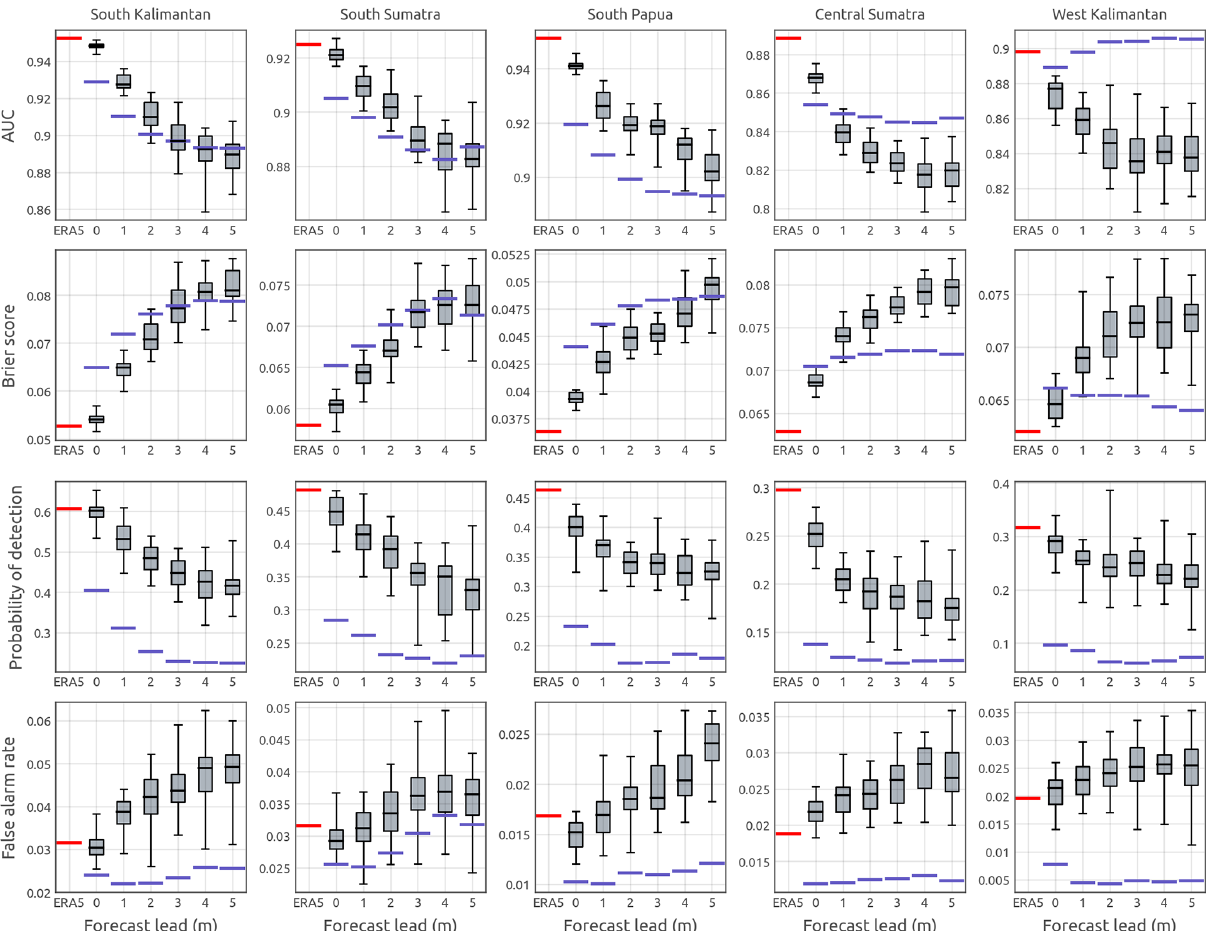
Figure 7. Skill scores for prediction of an active-fire count of > 10 cases. Shown are mean values of the area under the receiver operating characteristic curve (AUC), Brier score, probability of detection and false-alarm rate (figure rows) for the different sub-regions (figure columns). ROC curves are shown in Fig. S2 in the Supplement. The values for ERA5-based model predictions are shown as red bars, and climatology-based predictions are depicted as blue bars, while boxplots indicate SEAS5 ensemble member prediction values at different lead times. For boxplots, shown are the median value (grey bar), interquartile range (boxplot body) and the full range (boxplot whiskers) of the SEAS5 ensemble member predictions at a given lead